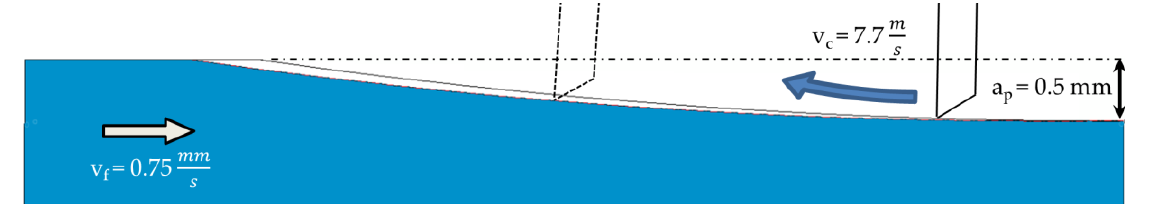
Figure 4. Cutting geometry for single-tooth circumferential milling.